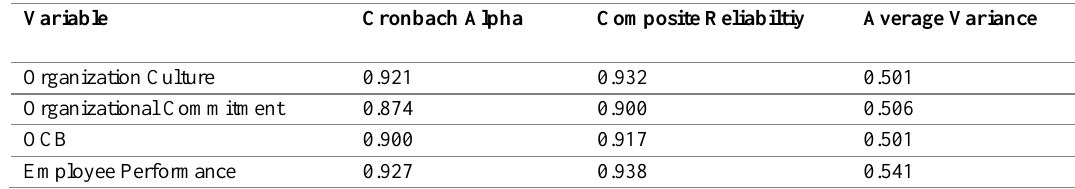
Table 1: Cronbach Alpha, Composite Reliability, Average Variance